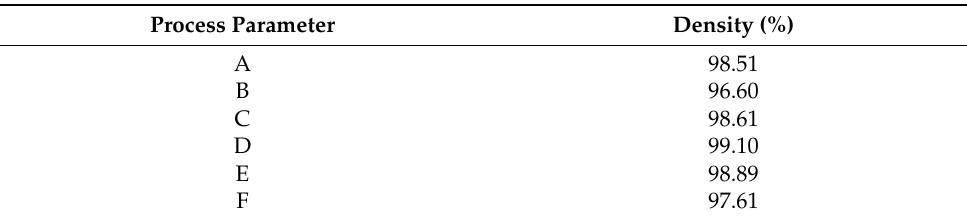
Table 6. Results of the density measurements of Modification II specimens, done with image process- ing. The process parameters used are listed in Table 2.